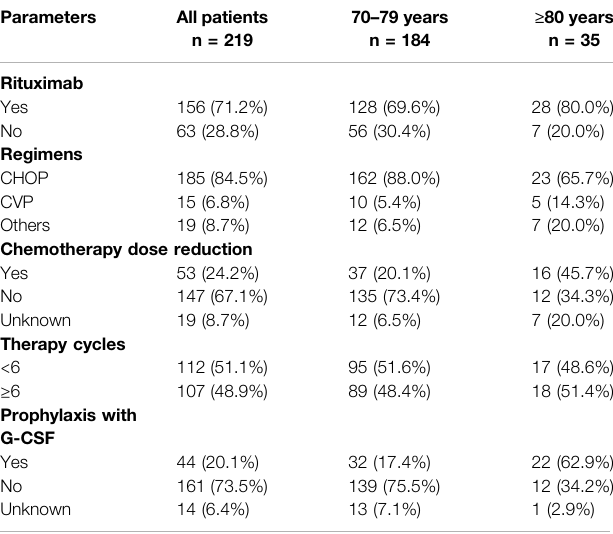
TABLE 2 | Initial treatment regimens of patients with DLBCL (n=239). Parameters